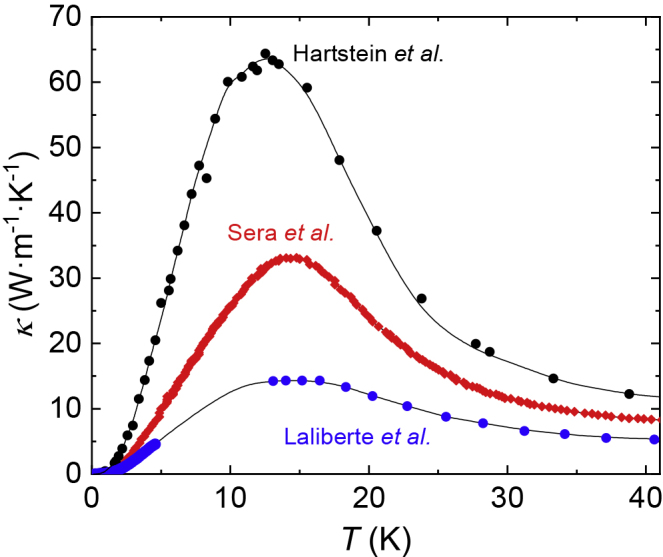
Comparison of High Temperature Thermal Conductivity Phonon Peak in SmB6 Single CrystalsThermal conductivity κ as a function of temperature for a floating zone-grown SmB6 single crystal from the same batch as single crystals on which we measure quantum oscillations (black circles (Hartstein et al., 2018; Hatnean et al., 2013)), compared to the thermal conductivity measured for floating zone-grown samples in previous studies (red diamonds (Sera et al., 1996), blue circles (Laliberte et al., 2018)). The size of the peak is found to be largest for the floating zone-grown crystal used in our study, indicating high sample quality.